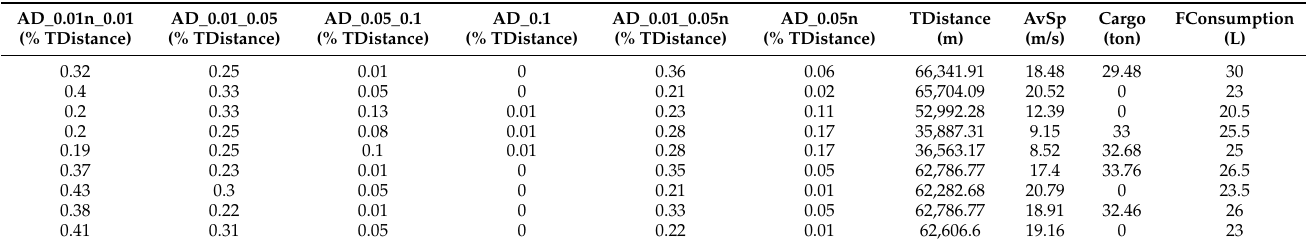
Table 5. Example of the values extracted from the training and testing